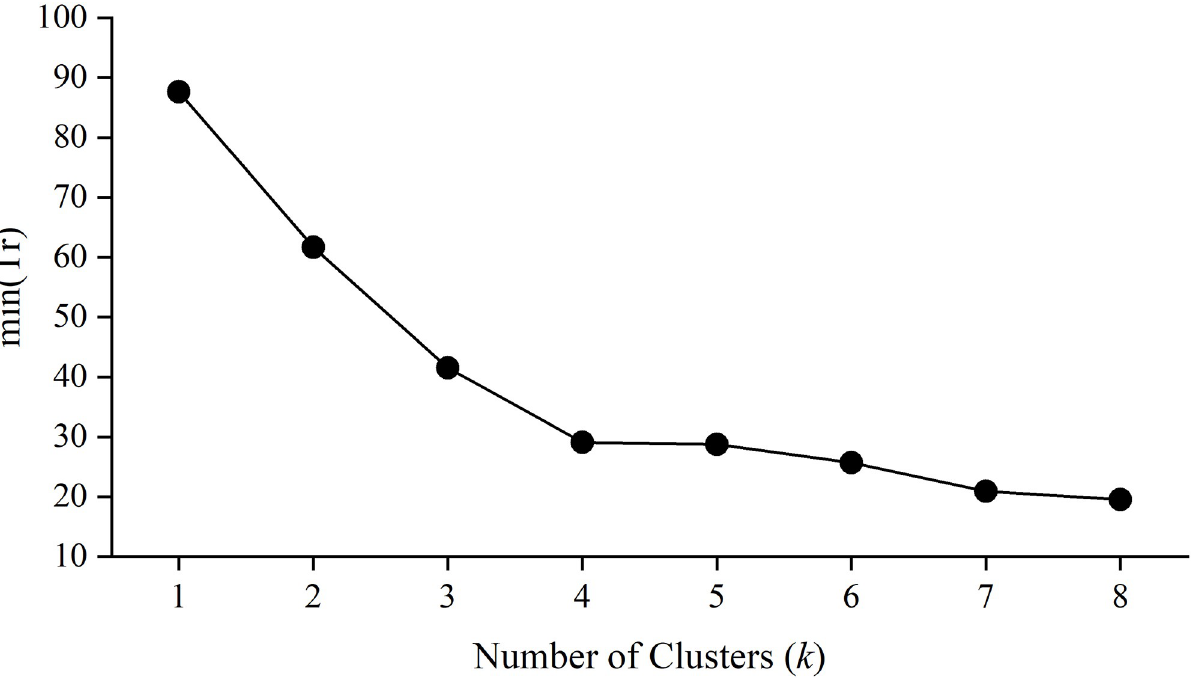
Fig 6. The elbow test for determination of the best number of